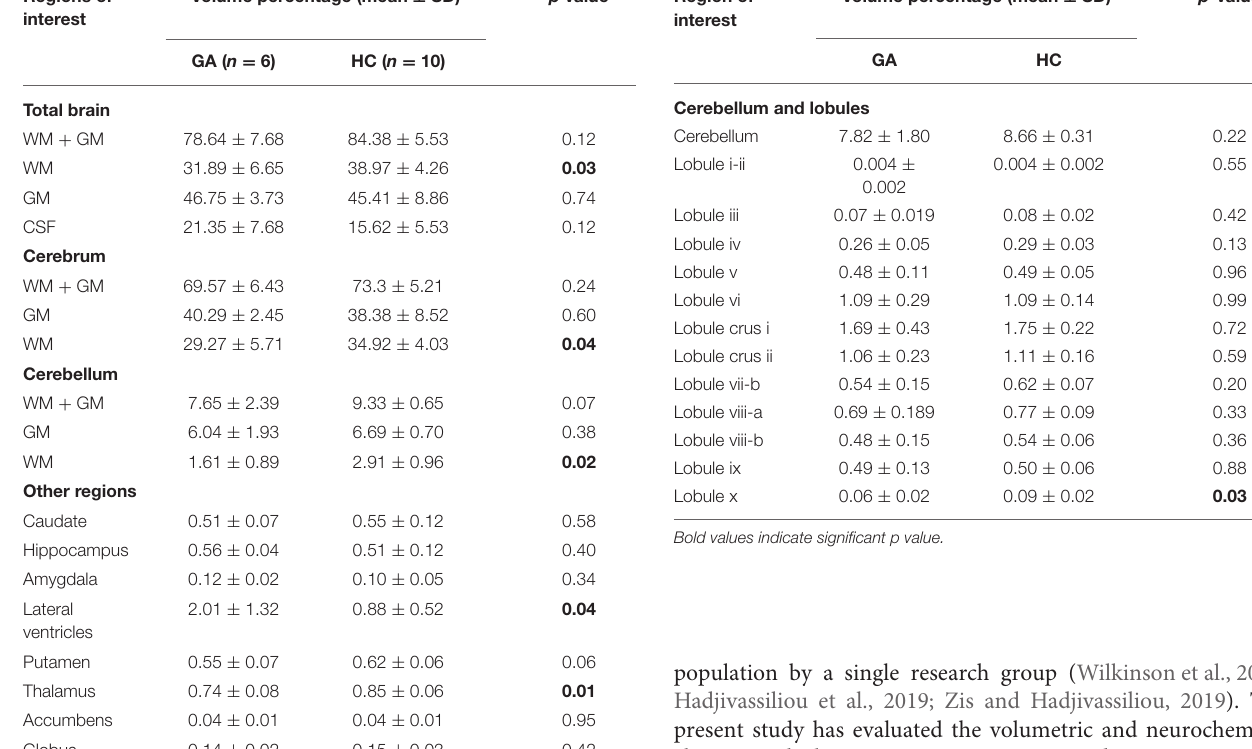
TABLE 2 | Volumetric analysis of individual brain regions of patients with Gluten Ataxia (GA) and Healthy Controls (HC). Regions of interest